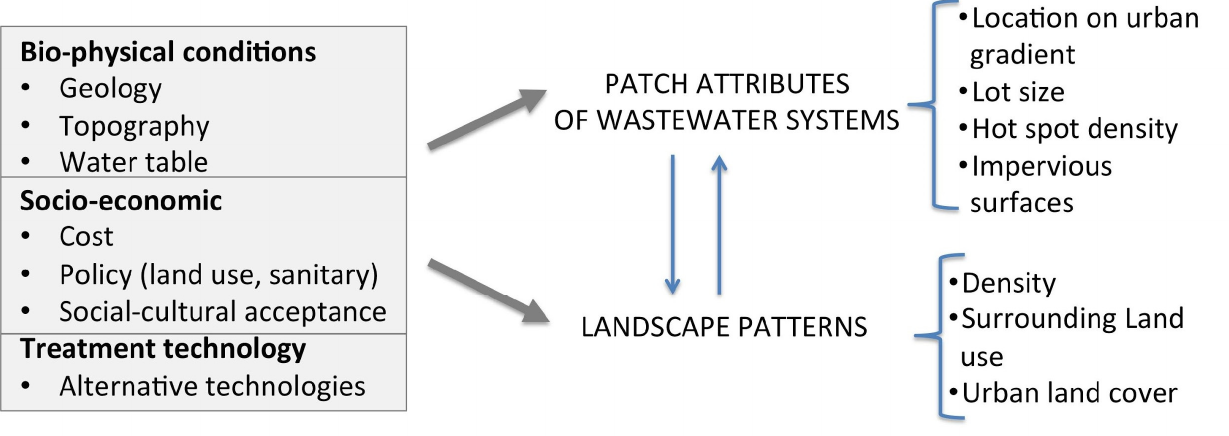
Figure 1. Conceptual framework of the regional-scale pattern of development associated with wastewater infrastructure, adapted from Spirandelli (2014)